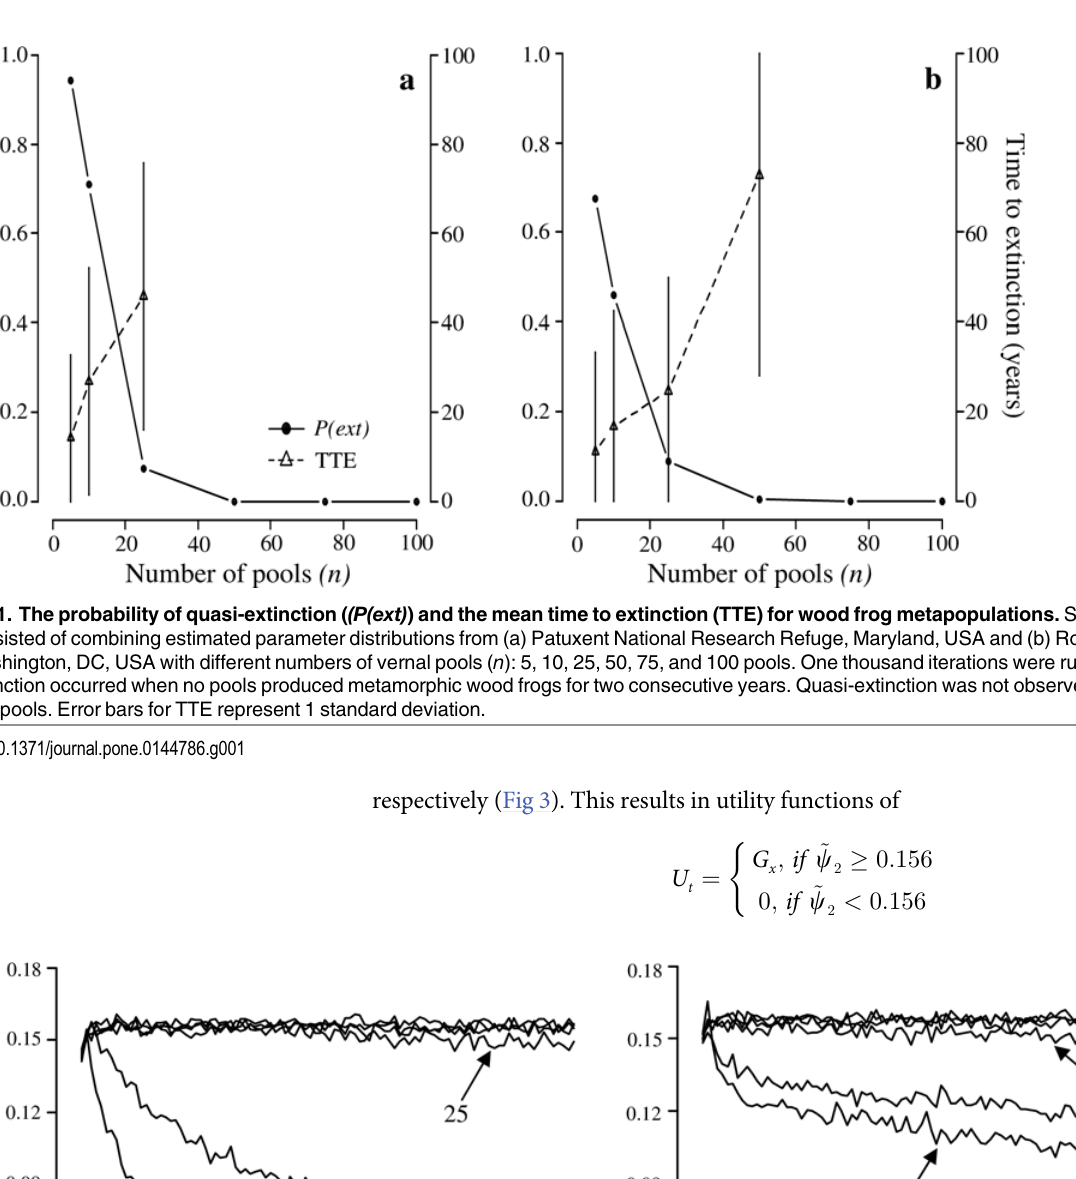
Fig 2. The mean proportion of vernal pools (from 1,000 iterations) supporting wood frog metamorphosis (metamorph occupancy rate, c simulations using occupancy estimates from (a) Patuxent National Research Refuge, Maryland, USA, (b) and Rock Creek Park, Washington, DC, USA, over a 100-year time horizon for scenarios with metapopulation sizes ( n ) of 5, 10, 25, 50, 75, and 100 pools. Labels represent the number of pools in the metapopulation, and overlapping lines represent scenarios for 50, 75, and 100